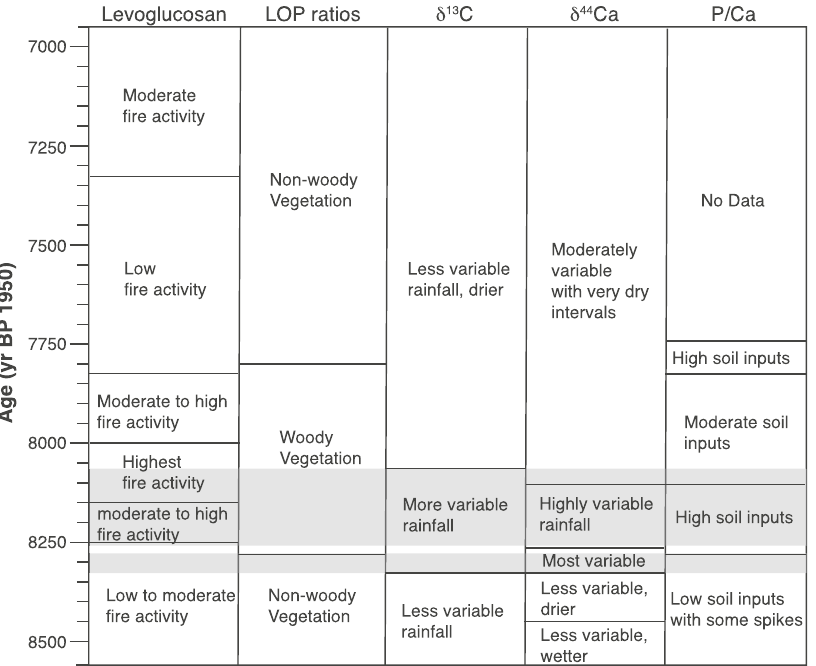
Fig.4|SummaryofproxyinterpretationsforstalagmiteWMC1withtime. Greyshadingdenotestheprecursorevent(centeredon8300yearsBP)andthe8.2kyrevent. See Fig. 1 for proxy